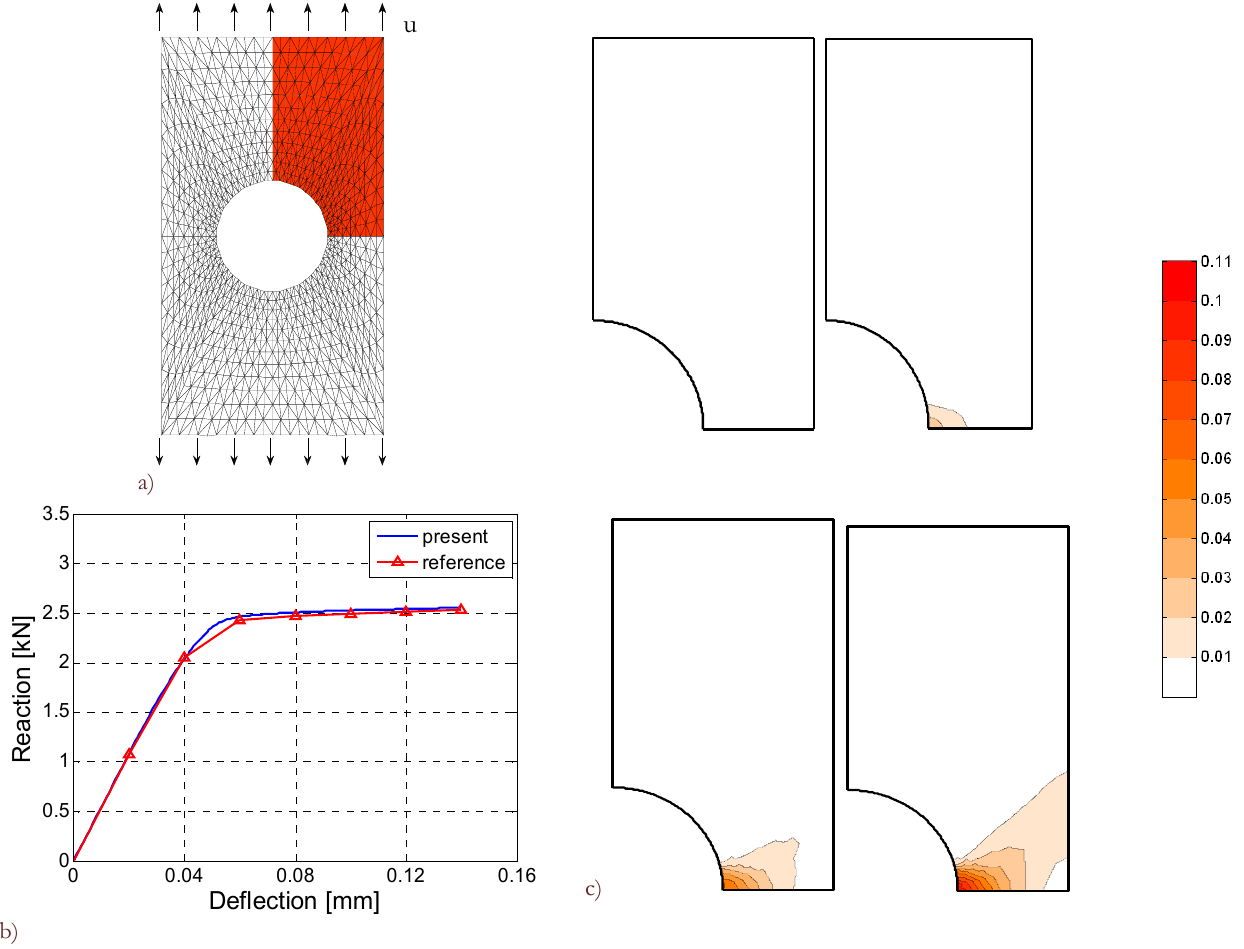
Figure 3: Stretching of a perforated rectangular plate. (a) Geometry, boundary conditions and finite element mesh; (b) Comparison of reaction-deflection diagram between the proposed algorithm and reference solution [10]; (c) Contour plot of accumulated equivalent plastic strain p ε at load level 15%, 45%, 75%,